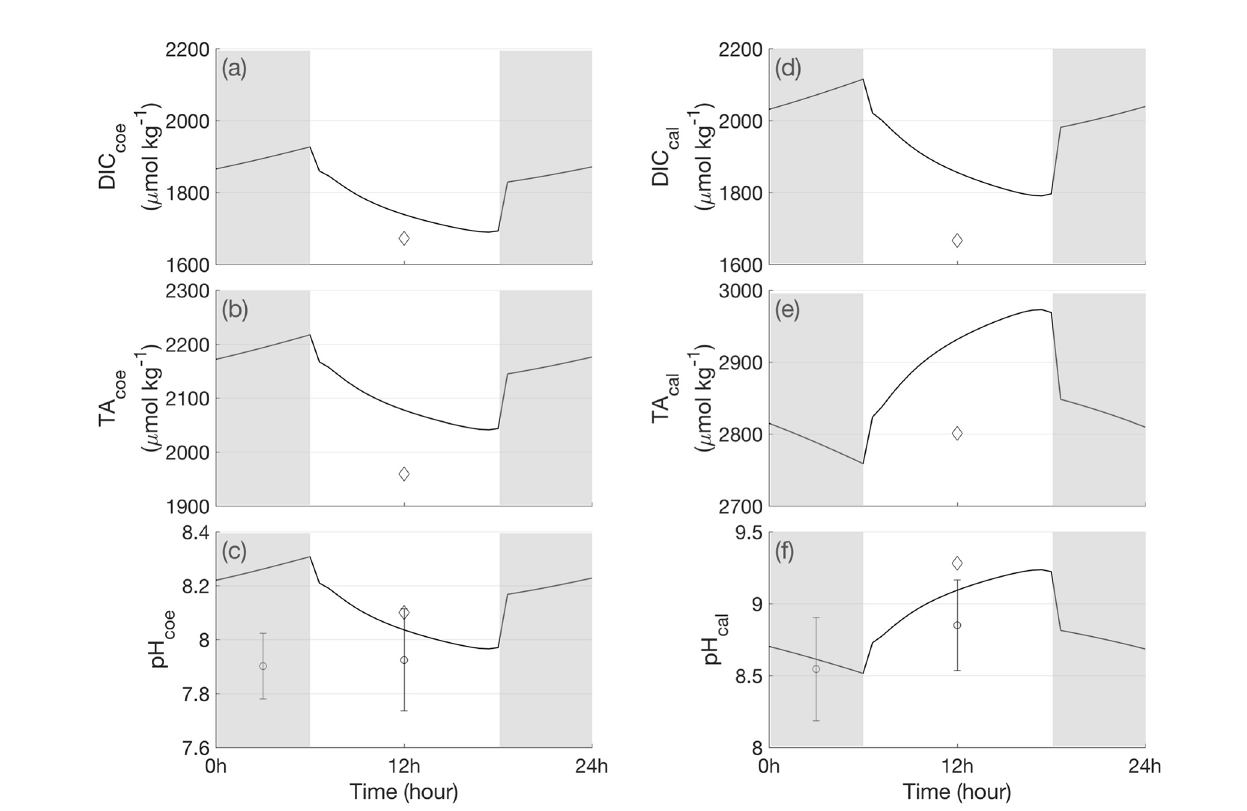
FIGURE 6 | A 24-h cycle of the simulated DIC, TA and pH in the coelenteron and calcifying fl uid. (A) DIC coe , (B) TA coe , (C) pH coe , (D) DIC cal , (E) TA cal , (F) pH cal . The diamond sign indicates the measured DIC, TA, pH in different polyp component in under light in Cai et al. (2016). The dot with stand deviation bar denotes the pH measurements in Al – Horani et al., 2003. The shaded bars indicate bark